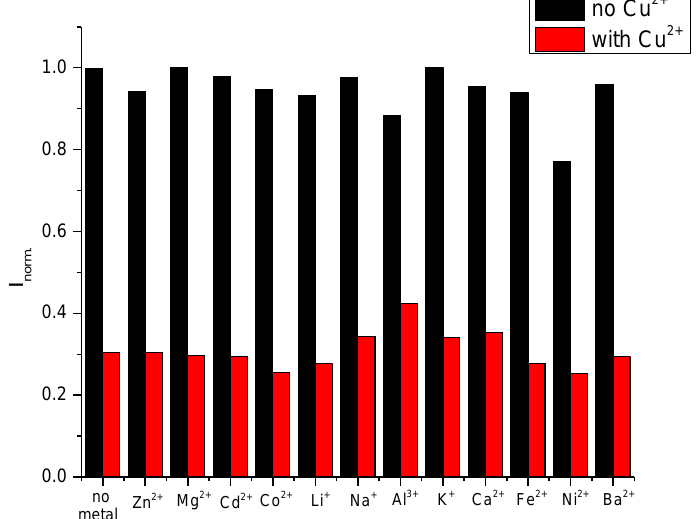
Figure 3. Competitive binding of 4 to 2 equivalents of Cu 2+ , in the presence of 5 equivalents of other divalent metal ions.